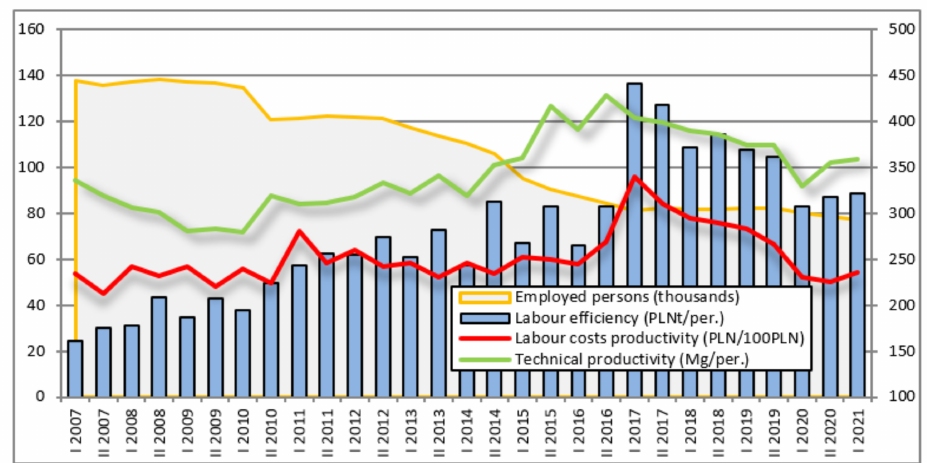
Figure 6. Employees, labour efficiency, labour costs productivity and technical productivity in coal mining companies in 2007–2019 (half-year data). Note: employees—left axis (thousands). Source: as in Figure